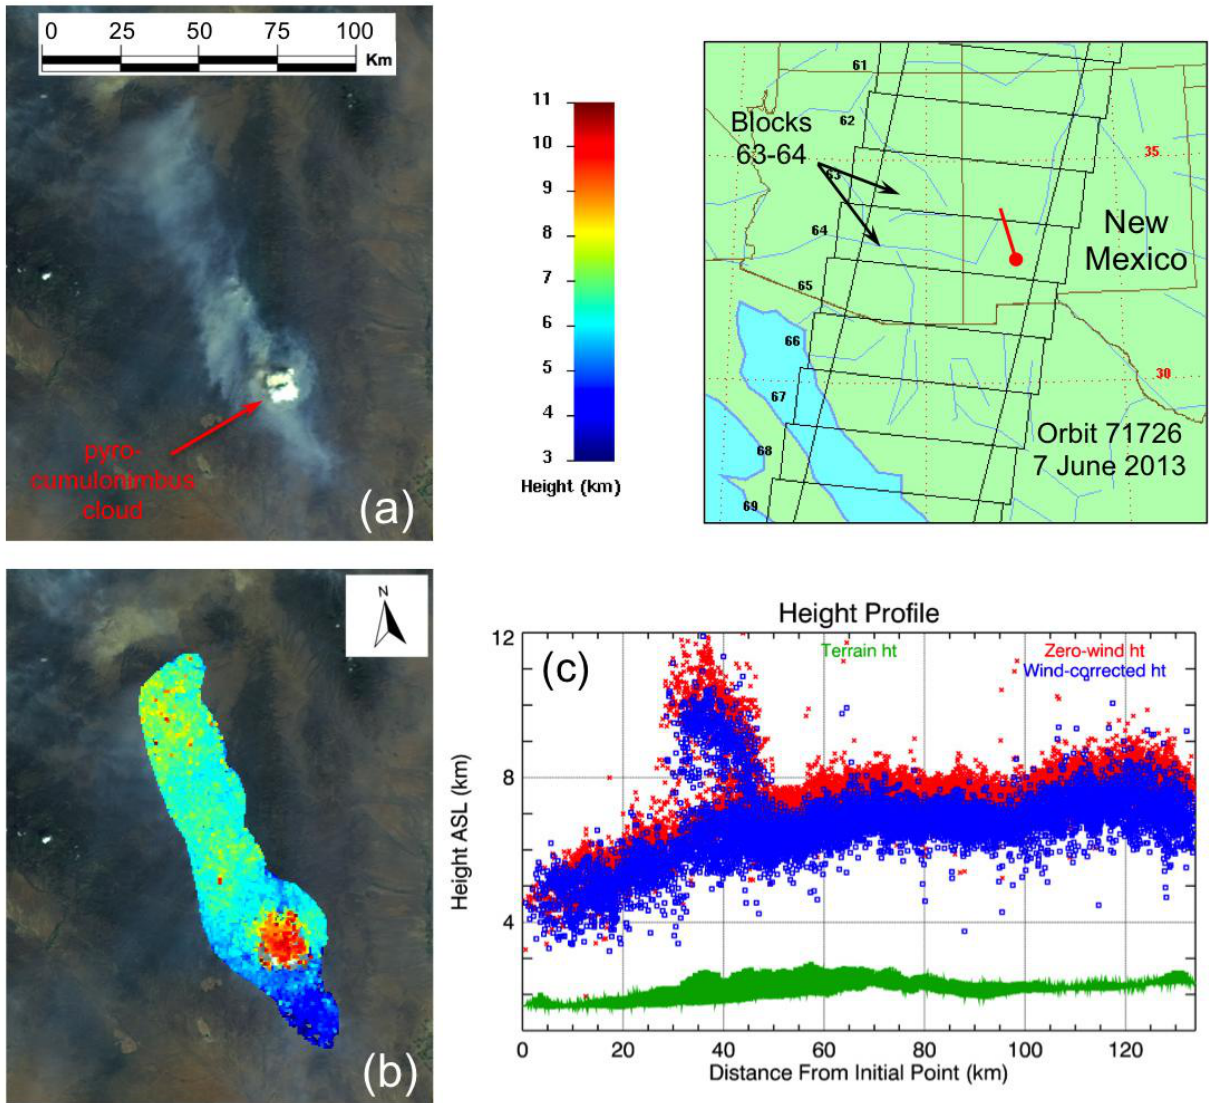
Figure 17. Pyrocumulonimbus (pyroCb) cloud associated with the Silver Fire in New Mexico on MISR orbit 71726, block 63–64, from 12 July 2013: ( a ) MISR nadir RGB image showing the smoke plume in gray colors and the pyroCb in bright white; ( b ) MINX height retrievals showing that the pyroCb is much higher than the surrounding smoke; ( c ) MINX height retrieval profiles showing the dramatic difference in the heights which reach 11–12 km ASL for the pyroCb, but only 6–7 km ASL for smoke in the